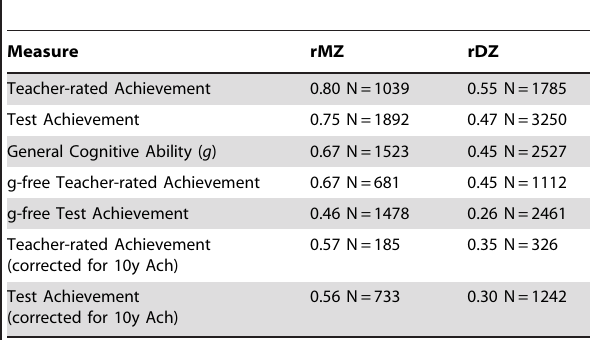
Table 3. Intraclass twin correlations for 12-year achievement, general cognitive ability (g), and for achievement corrected for g and achievement corrected for previous